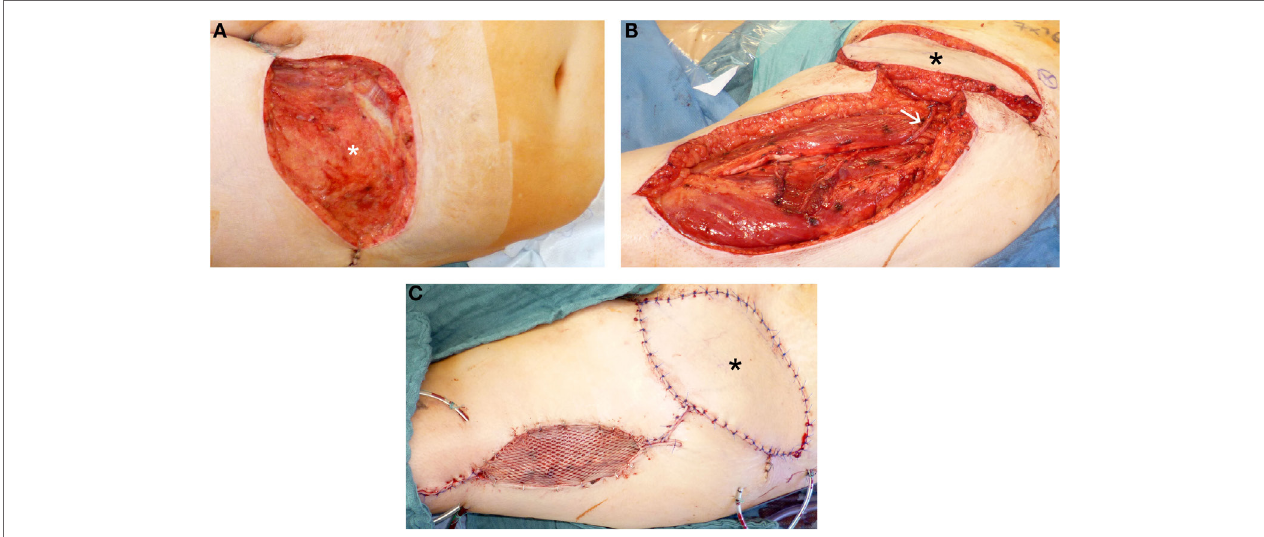
FiGURe 2 | Defect reconstruction at groin after resection of a dermatofibrosarcoma protuberans using caudal pedicled ALT flap . (A) Extent of groin defect after resection (black asterisk) of a dermatofibrosarcoma protuberans. (B) Intraoperative view after dissection of ALT flap and rotation into the groin defect. For typical manner of harvesting ALT flap, ALT perforator is localized between the central to lower third of the ALT flap area after skin incision and initial preparation. White arrow shows the ALT perforator. (C) Intraoperative view at the end of the operation with ALT flap (black asterisk) and skin graft at donor site to reconstruct groin